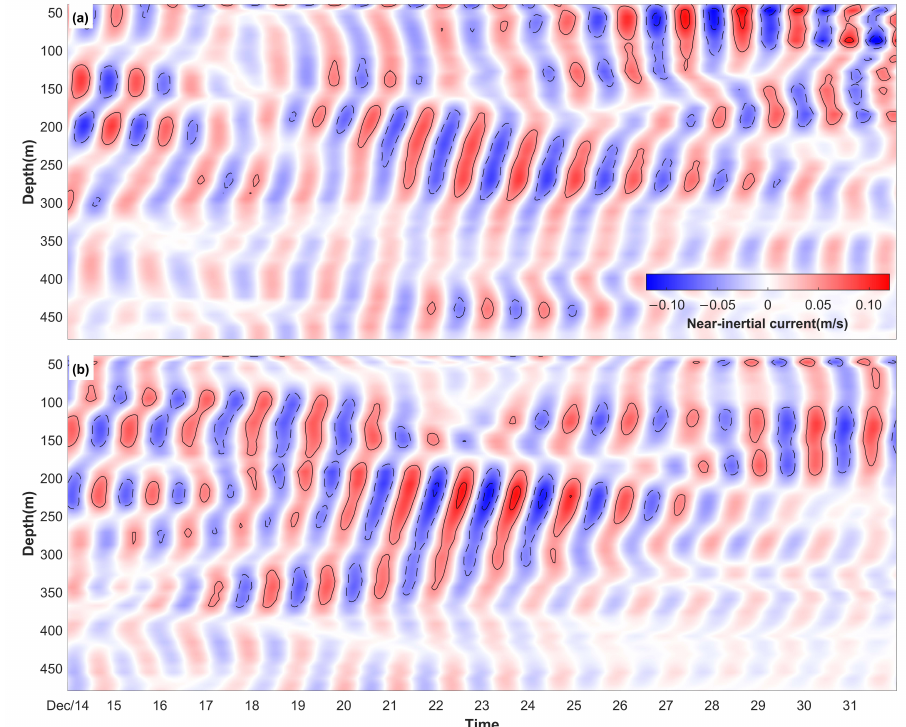
Figure 16. Zonal ( a ) and meridional ( b ) near-inertial currents in December 2017. The contours start at ± 0.05 m/s with a stride of 0.05